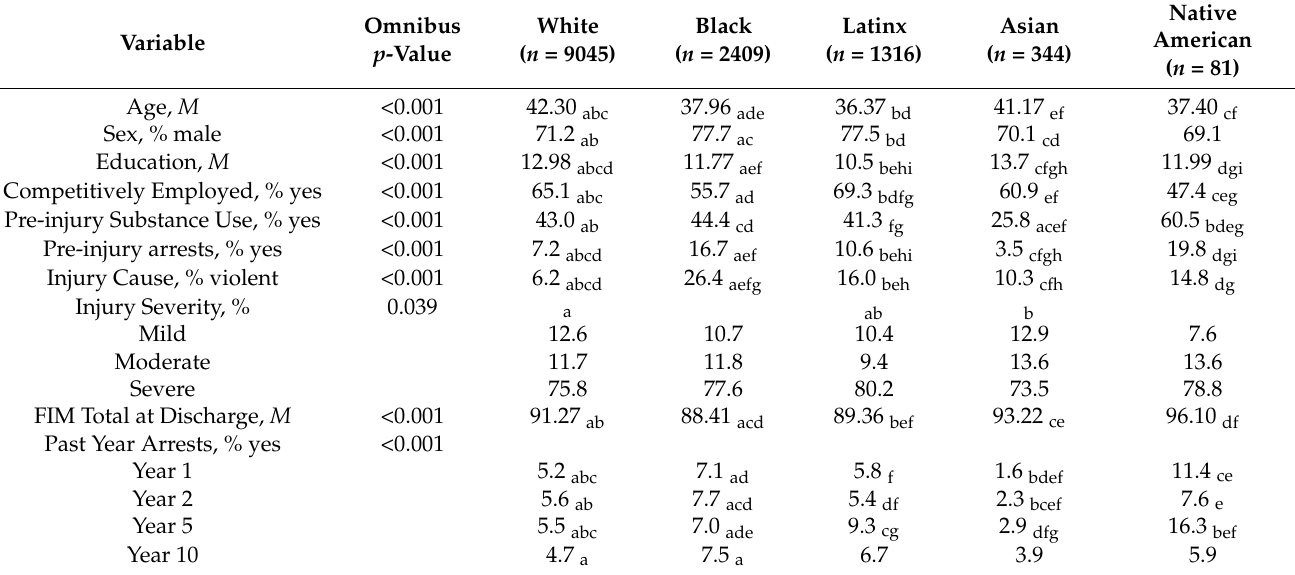
Table 1. Sample demographic and injury